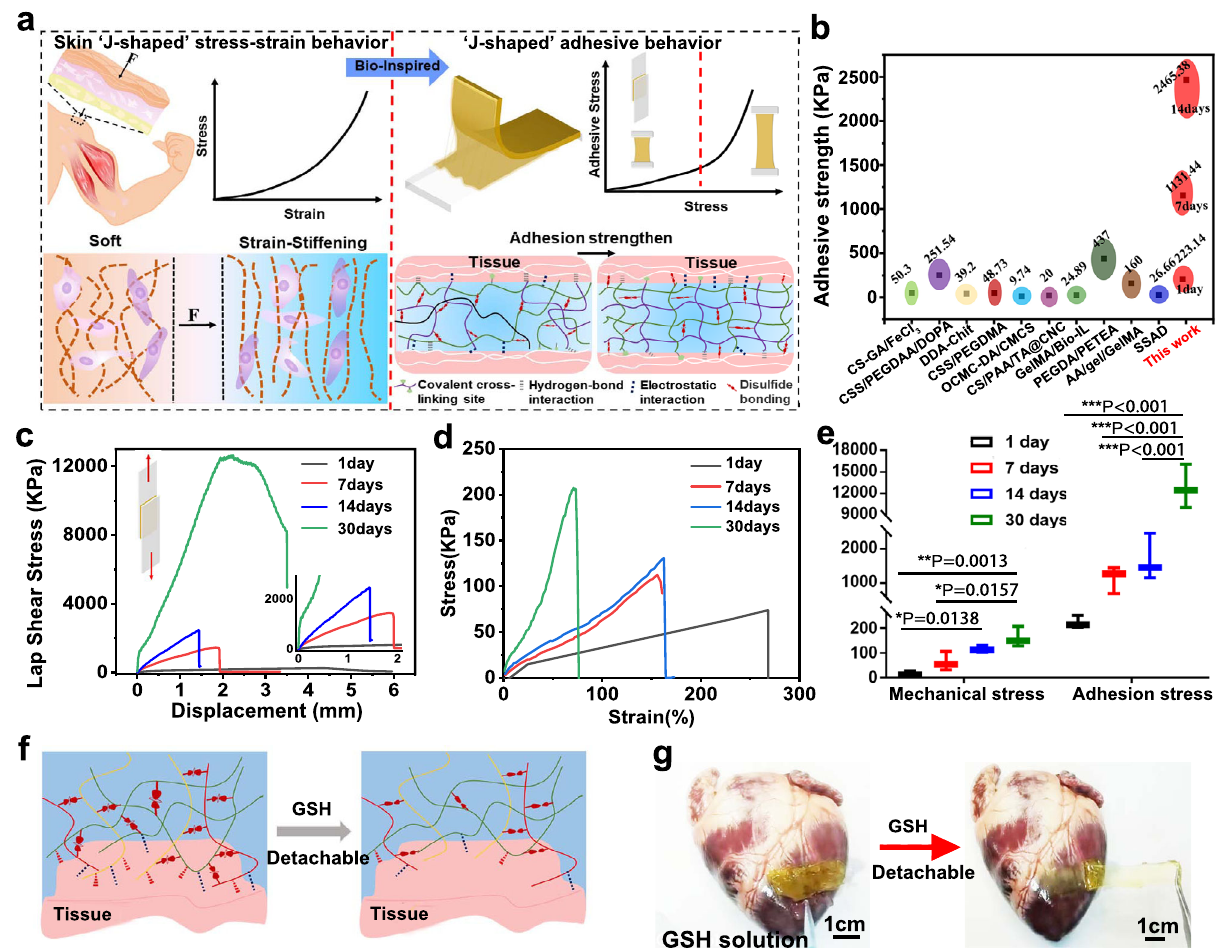
Fig. 3 | Insight into developing CPAMC superglue mimicking from skin scler- otization process. a Schematic illustration of strain-stiffening behavior of CPAMC hydrogel. b Comparison of adhesion strengths of our CPAMC in gluing glass with the literature values 13,33,54 . c Adhesive strength of CPAMC hydrogel in glass in air conditionwithdifferentcontacttime. d MechanicalstrengthofCPAMChydrogelin glass in air condition with different contact time. e Statistical analysis of adhesive strengthand mechanicalstrengthof CPAMC hydrogelinglassinairconditionwith differentcontacttime(errorbarmeansthestandarddeviation,* p <0.05,** p <0.01,